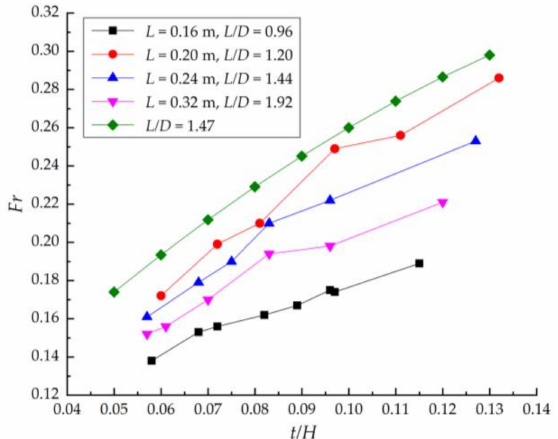
Figure 10. The calculated critical Fr at L / D = 1.47 and the critical Fr obtained from